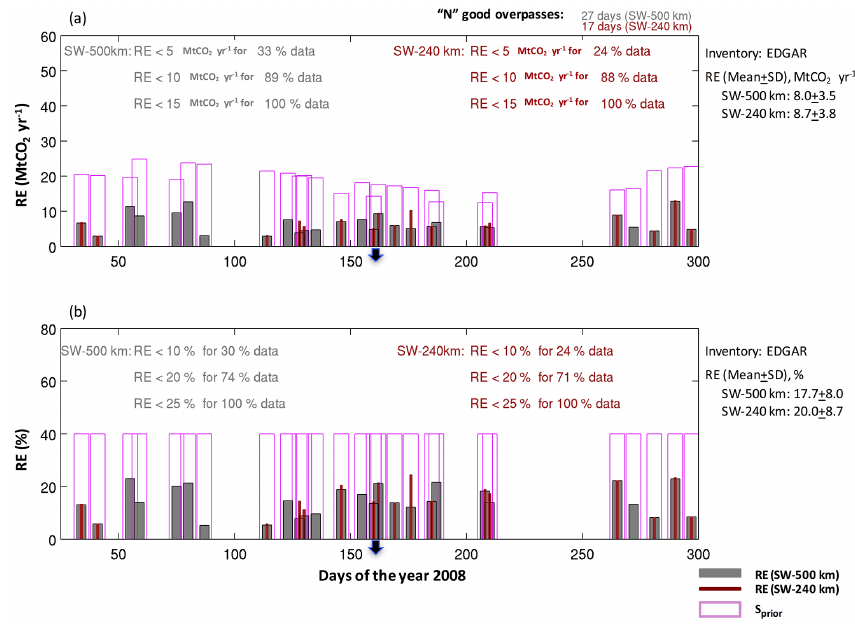
Figure 6. Precision (random errors (RE)) of the retrieved emission fluxes obtained by the inverse optimization using 1 year of CarbonSat simulated observations. Results of two different swath widths (SWs) – 500km (grey) and 240km (red) – are shown. S prior values are indicated with magenta-bordered bars for visualizing the reduction in uncertainty. The top and bottom panels show RE in MtCO 2 yr − 1 and in percent, respectively. An overview of the statistical distribution of RE, separately for 500km (grey) and 240km (red) swath widths, is given inside the panel. The overall mean ± standard deviation is given outside the respective panels. The lower and upper limits of the x axis (days of the year) is restricted accordingly as there are no good CarbonSat simulated observation during winter months. The arrow marker in the x axis indicates a particular day (24 June 2008) shown in Figs. 4, 7, and